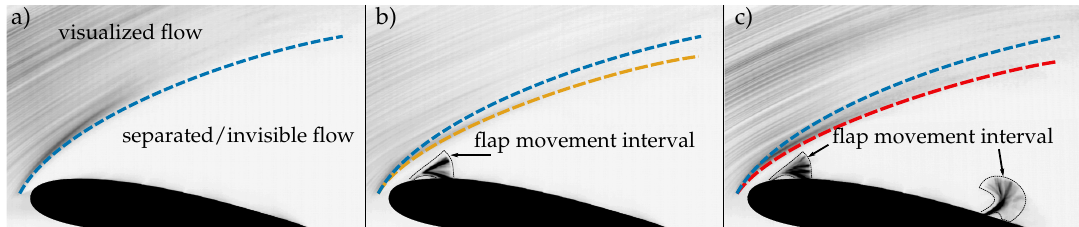
Figure 10. Inverted visualization of the averaged flow at the angle of attack of 25°; ( a ) flapless airfoil, ( b ) LE configuration, and ( c ) LETE configuration; the dashed blue line shows the visible border of the separated flow for a flapless airfoil; the dashed orange and red lines show the visible borders of the separated flows for the LE and LETE configurations; additionally, the flap movement intervals of the flaps at the leading and trailing edges are emphasized by the black framing around